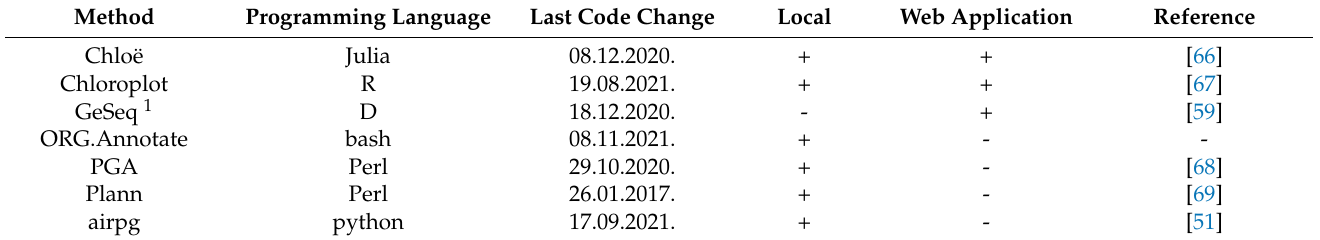
Table 10. Chloroplast annotation tools used in the